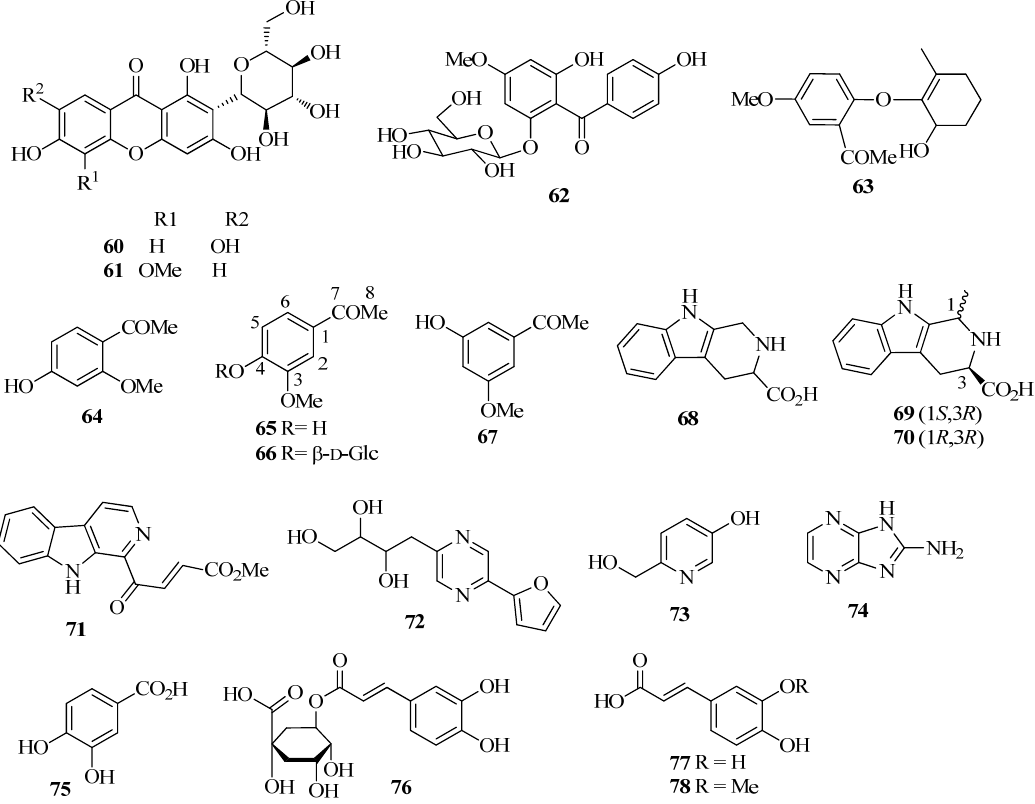
Figure 4. Miscellaneous aromatic compounds isolated from Iris germanica .